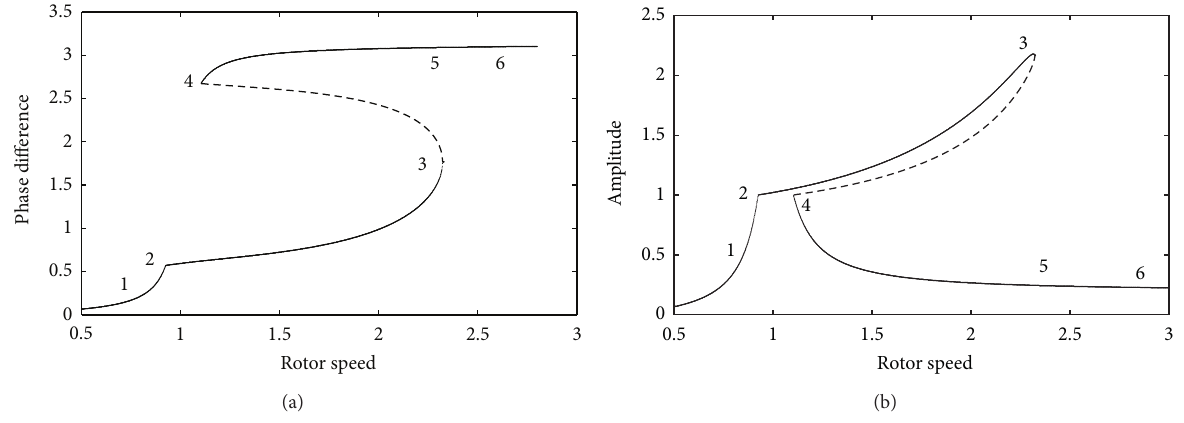
Figure 2: (a) Phase difference shift depending on rotor speed; (b) radial displacement amplitude depending on rotor speed.